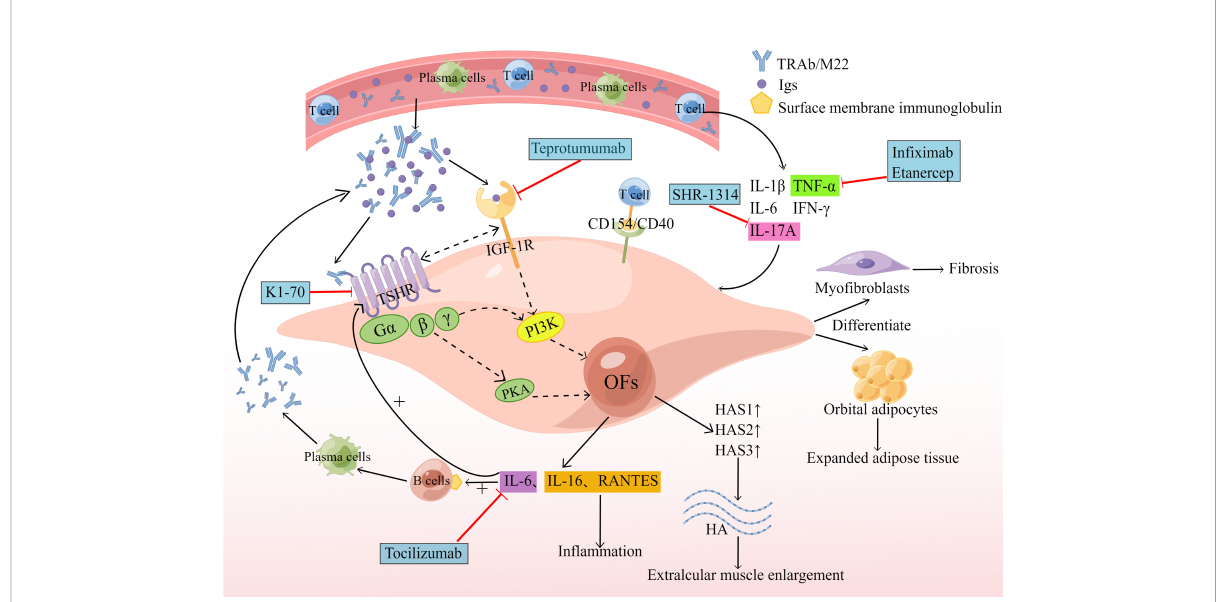
FIGURE 2 Humoral immunity and biologics. The circulating TRAb and M22 act on TSHR to induce cAMP production, which activates the PI3K cascade reaction and promotes the production of HAS1, HAS2 and HAS3, resulting in increased production of hyaluronan, leading to extraocular muscle hypertrophy. M22 also increases the expression and secretion of IL-6. Subsequently, the increased expression of IL-6 promotes the expression of the autoantigen TSHR by OFs and also drives B-cell immunoglobulin (Ig) production, and plasma cell development. Serum Igs from GO patients bind to IGF-1R and produce IL-16 and RANTES, promoting an in fl ammatory response. TSHR and IGF-1R can form physical and functional protein complexes that can interact to increase signaling when activated by their respective ligands, resulting in increased hyaluronan (HA) and IL-6 production. The generated HA and IL-6 then repeat the above reaction, aggravating the GO pathological process. New therapeutic drugs are indicated by blue boxes and red lines. By Figdraw (www. fi